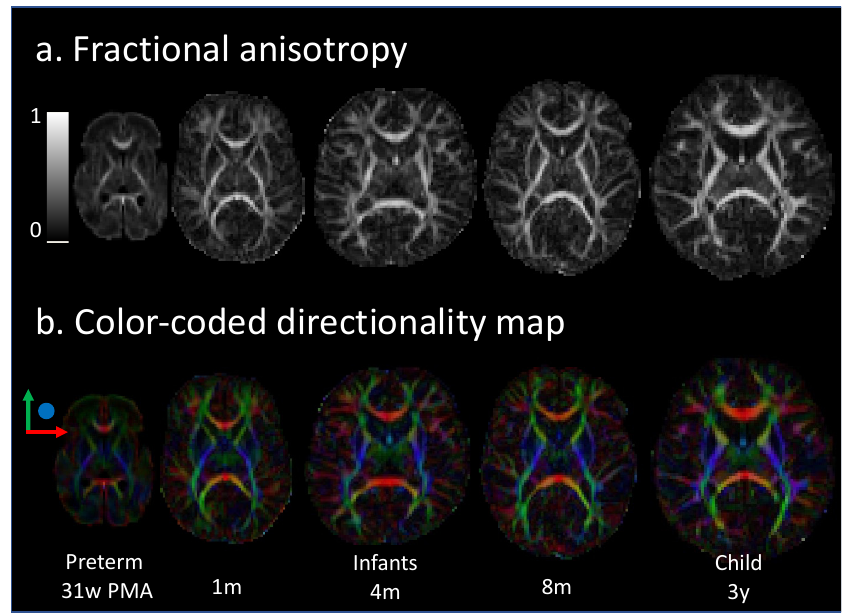
Figure 1. Evolution of DTI maps during development. Fractional anisotropy ( a ), and color-coded directionality ( b ) maps are illustrated according to the age—31 weeks of postmenstrual age, at 1, 4, and 8 months of age, and 3 years old. Adapted from ref. [36] .